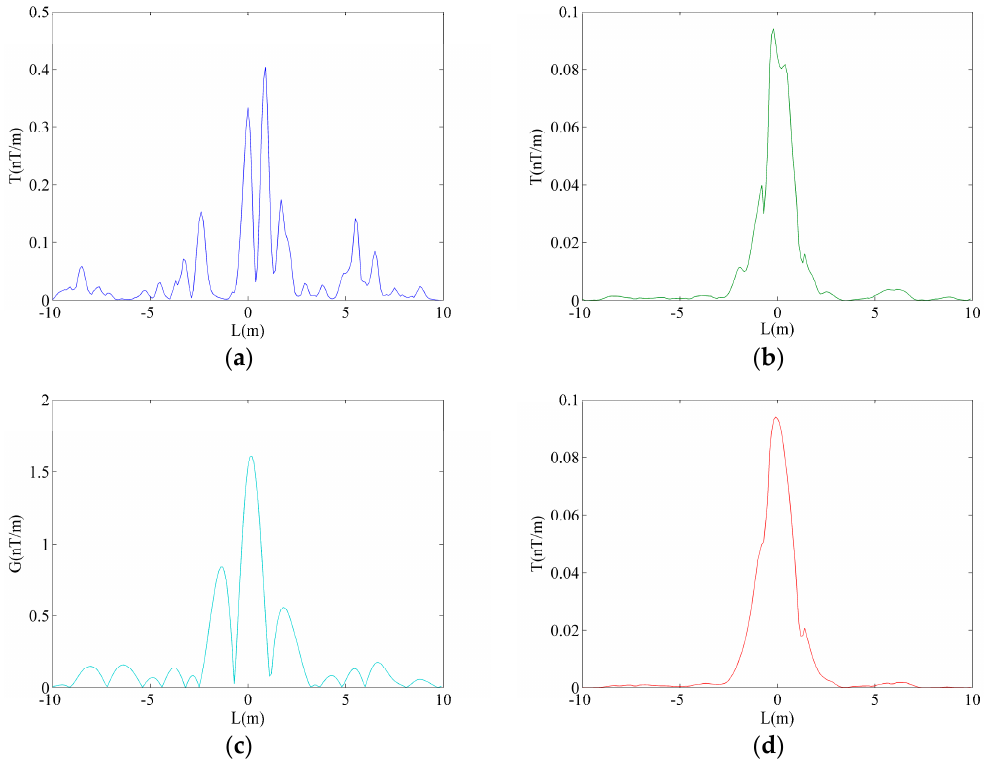
Figure 6. The four detection results for the simulation signal. ( a ) Conventional CEEMDAN denoising